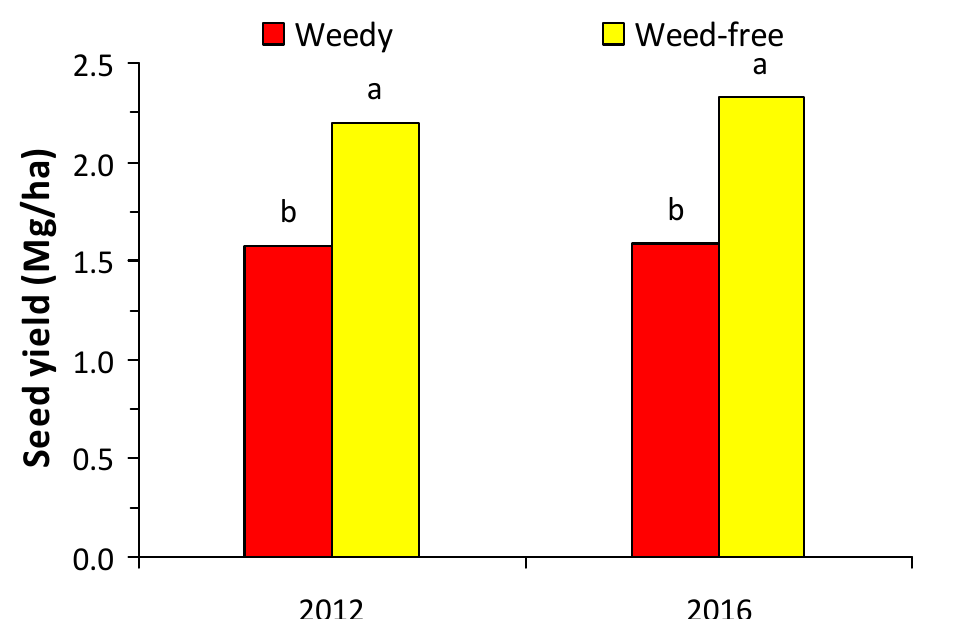
Figure 4. Seed yield of white lupine in weedy and weed-free treatments in the first and second growing seasons. Different letters in each growing season indicate statistically significant differences at p < 0.05.